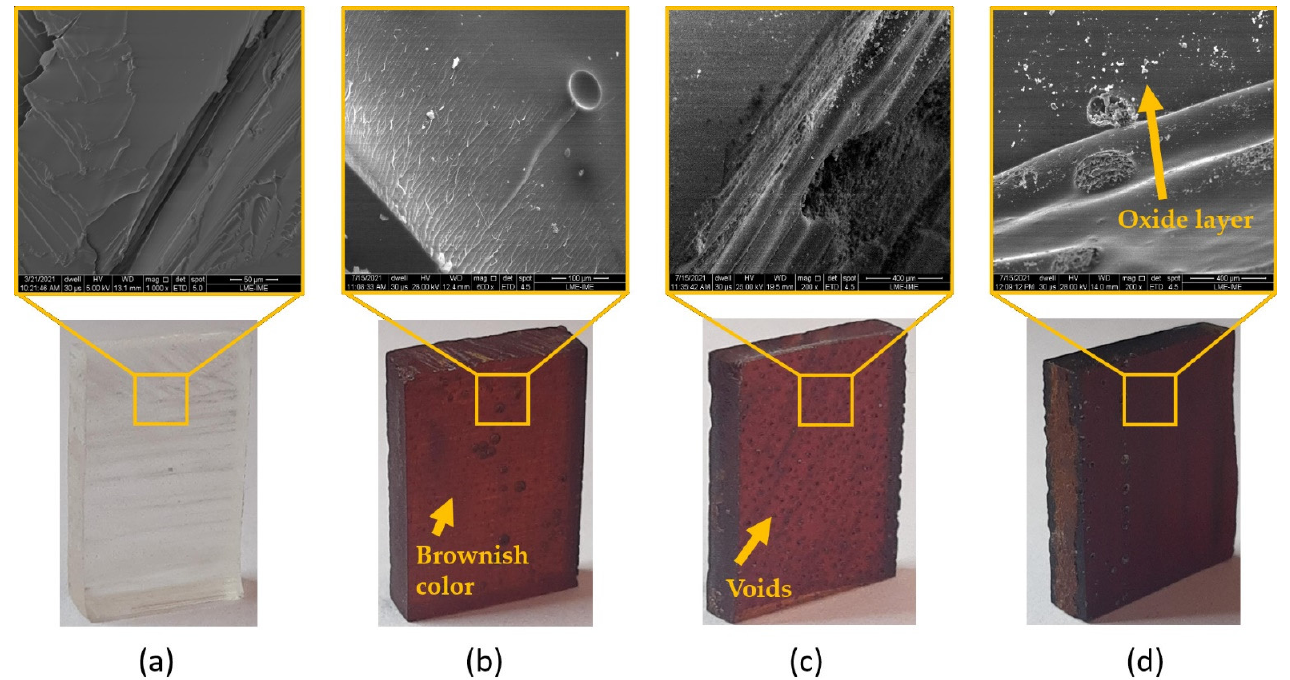
Figure 5. Visual changes and SEM micrographs of plain epoxy thermally aged in ( a ) 0 h; ( b ) 72 h; ( c ) 120 h; and ( d ) 240 h exposure time.